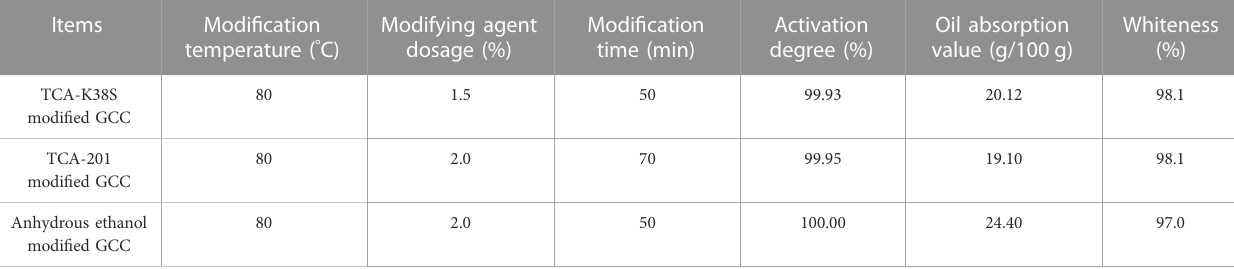
TABLE 6 The optimal modi fi cation scheme of modi fi ed GCC.